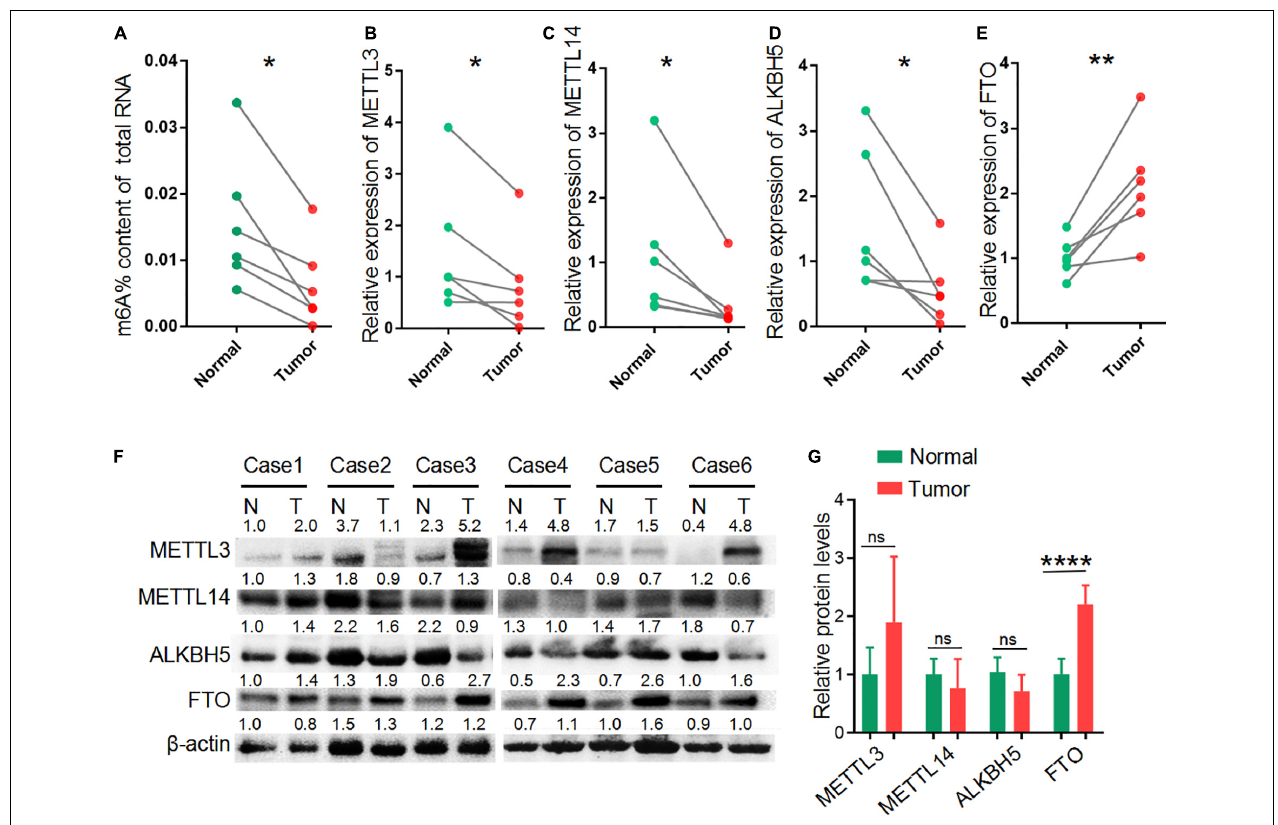
FIGURE 1 | Reduced m6A level in LUAD. (A) The global m6A level of total RNAs in six paired LUAD patient tumor tissues (Tumor) and matched adjacent non-tumor tissues (Normal). (B–E) The relative expression of METTL3, METTL14, ALKBH5 and FTO mRNA in six paired LUAD tissues compared with those in adjacent non-tumor tissues. (F) Western blot showing the protein expression of METTL3, METTL14, ALKBH5 and FTO in LUAD tissues (T) and adjacent non-tumor tissues (N). (G) Relative protein levels calculated based on the band density in western blot results. * P < 0.05, ** P < 0.01, and **** P <